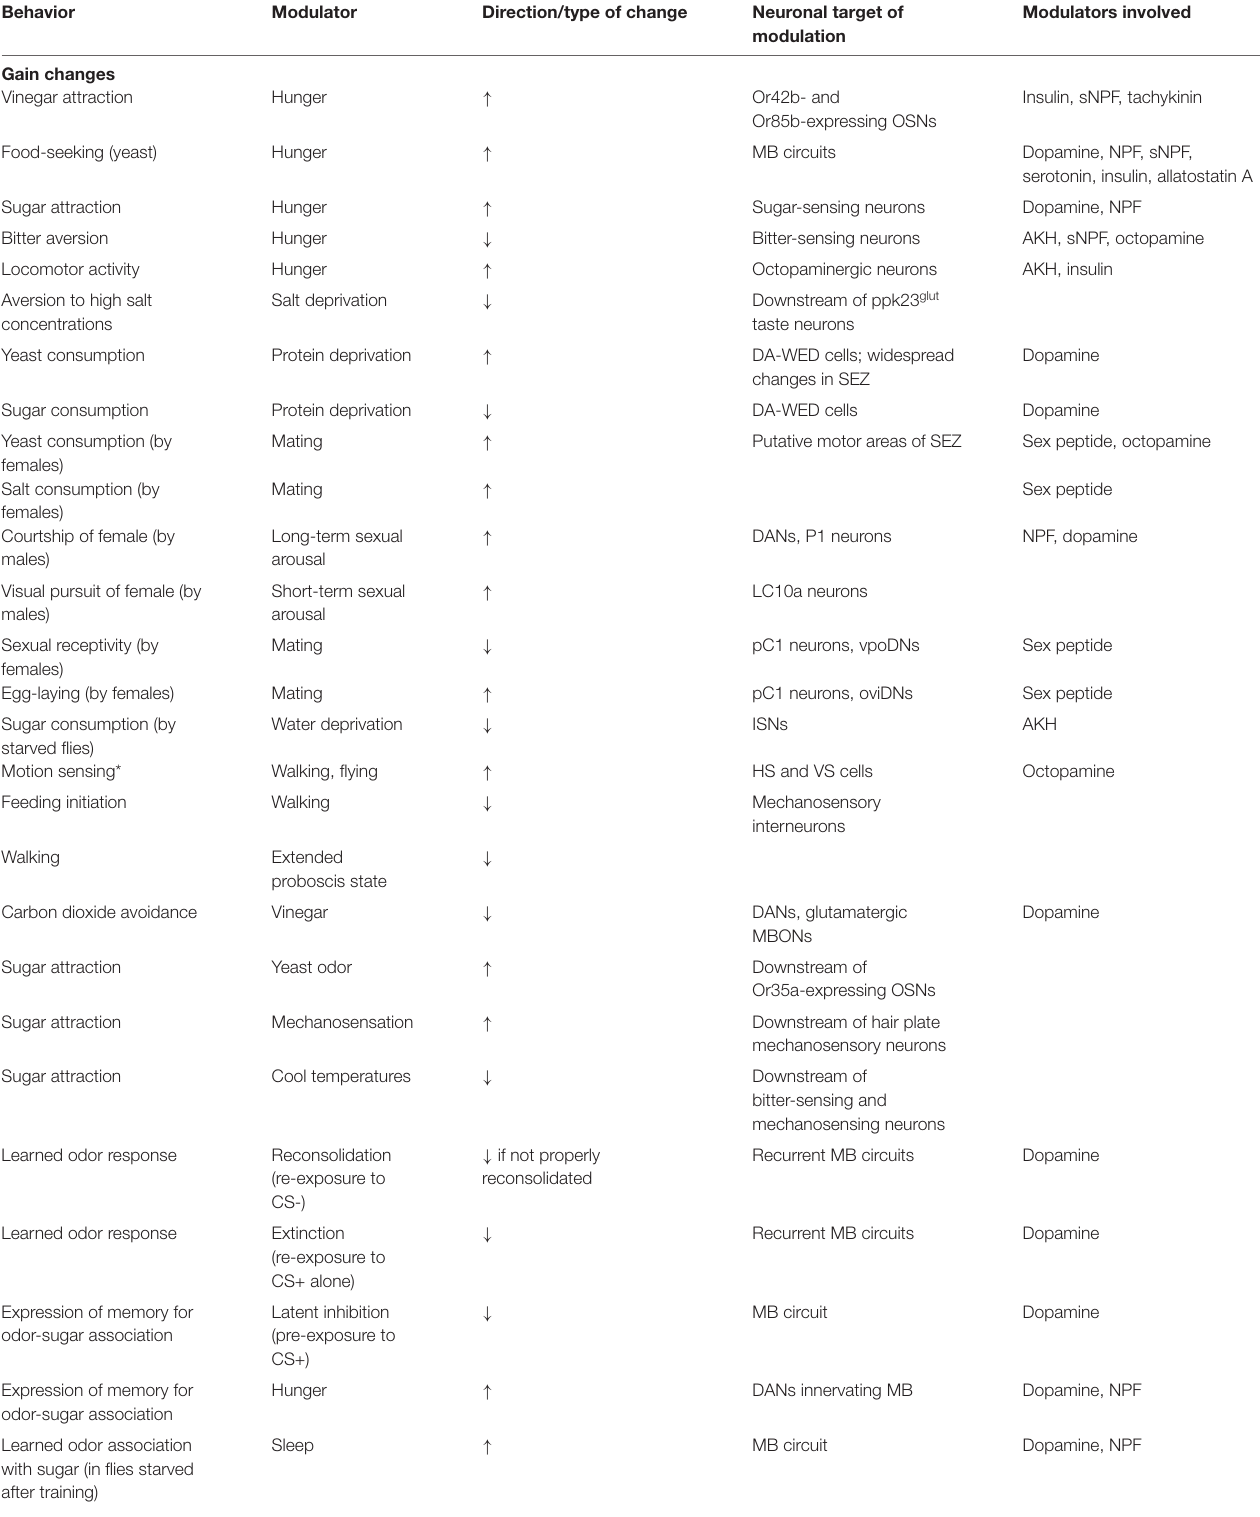
TABLE 1 | Examples of behavioral flexibility described in this